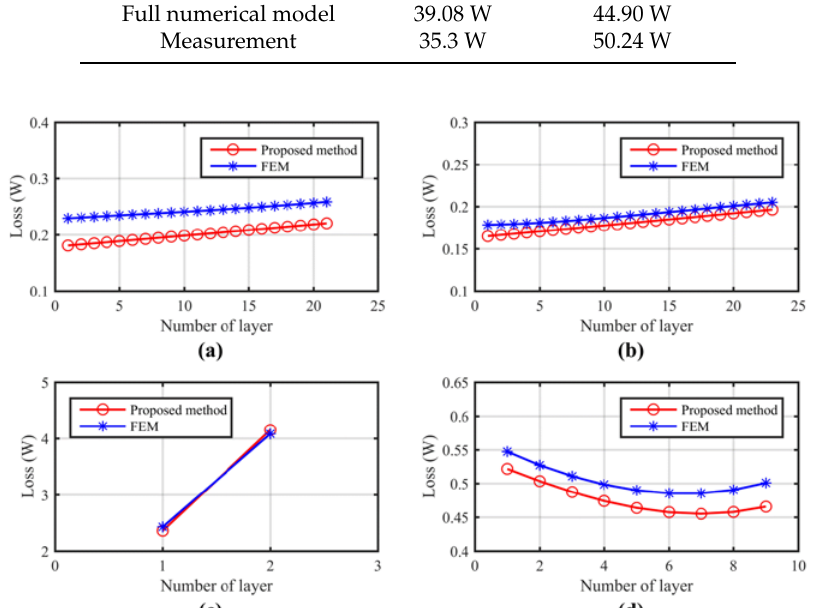
Figure 5. Losses of different winding layers: ( a ) low-voltage (LV) winding of prototype 1; ( b ) HV winding of prototype 1; ( c ) LV winding of prototype 2; and, ( d ) HV winding of prototype 2.